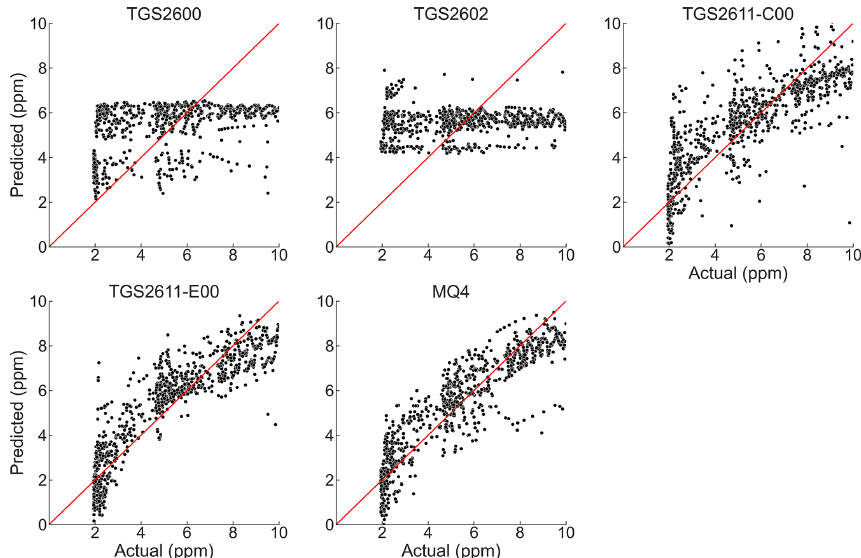
Figure 6. Regression performance using the coefficients given in Table 3, shown against the identity line. For visual clarity, only one replicate is shown for each sensor